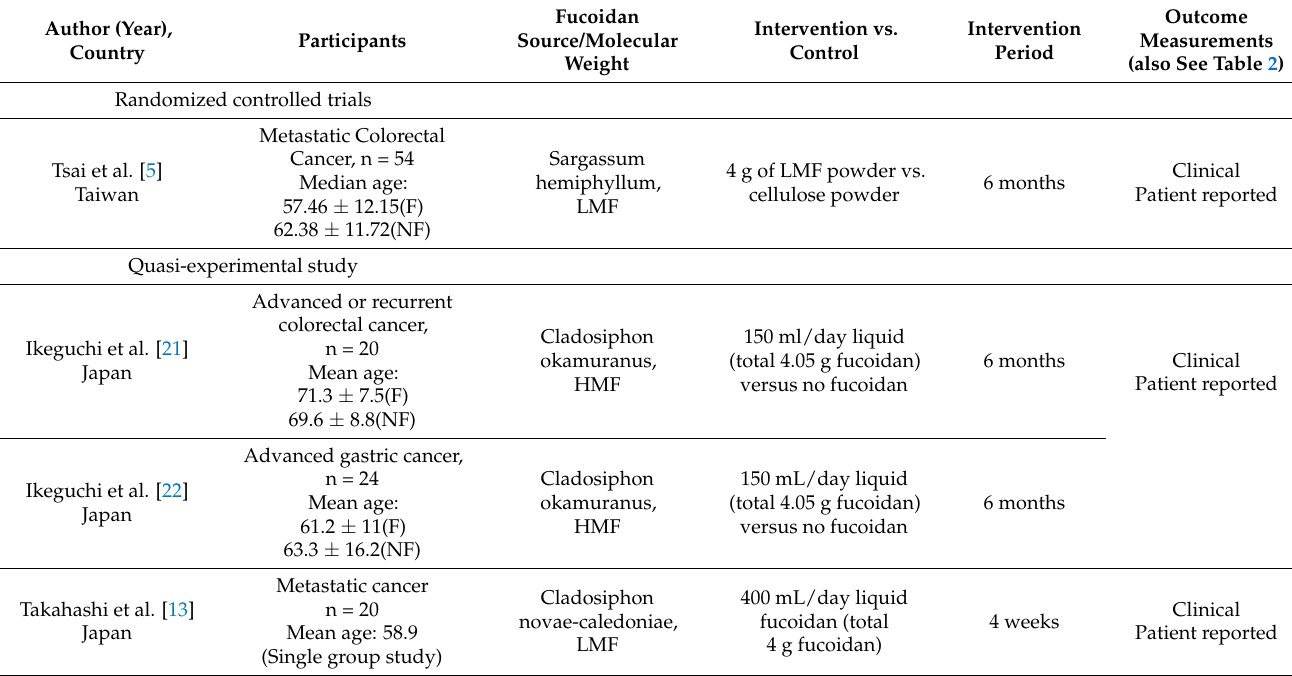
Table 1. Detailed information of included studies.